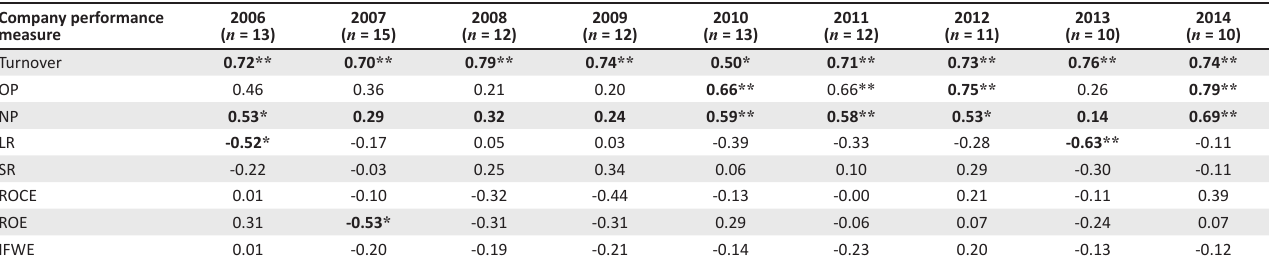
TABLE 5: Total remuneration and state-owned companies’ performance. Company performance measure